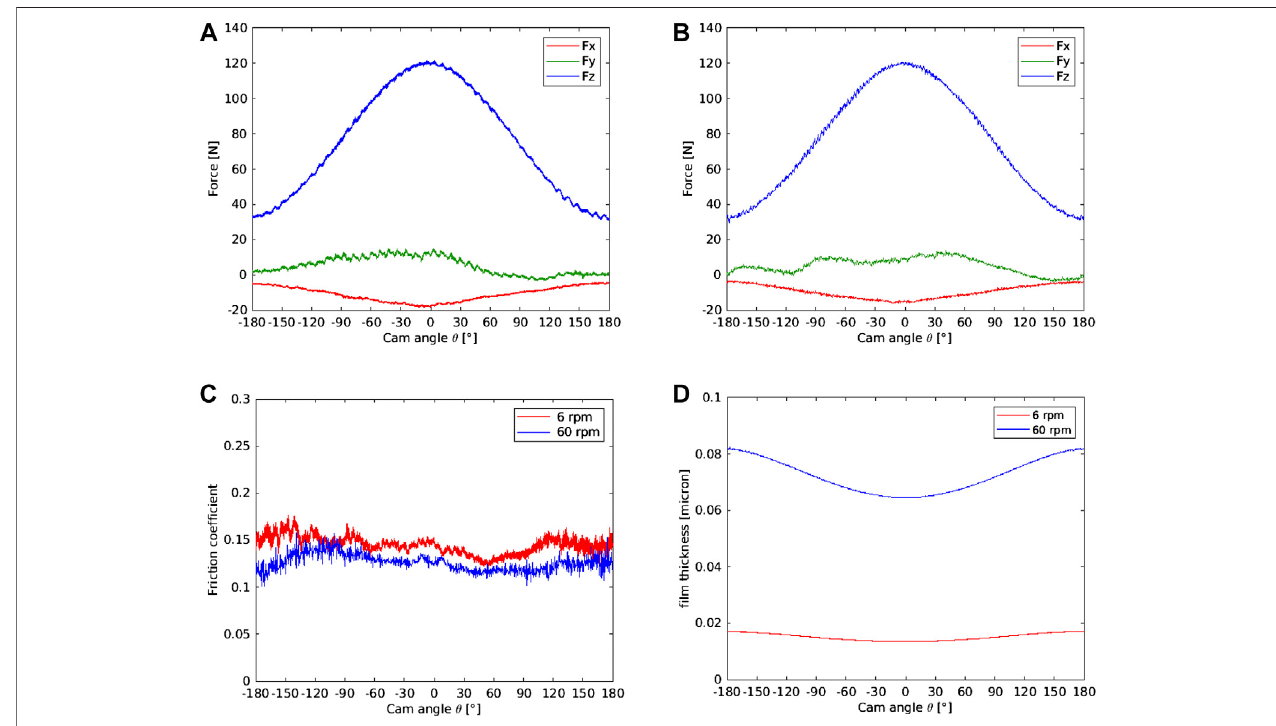
FIGURE 10 | Circular eccentric cam. Force components measured during a cycle at 6 rpm (A) and 60 rpm (B) . Friction coef fi cient trends (C) and calculated minimum fi lm thickness (D) at 6 and 60 rpm.